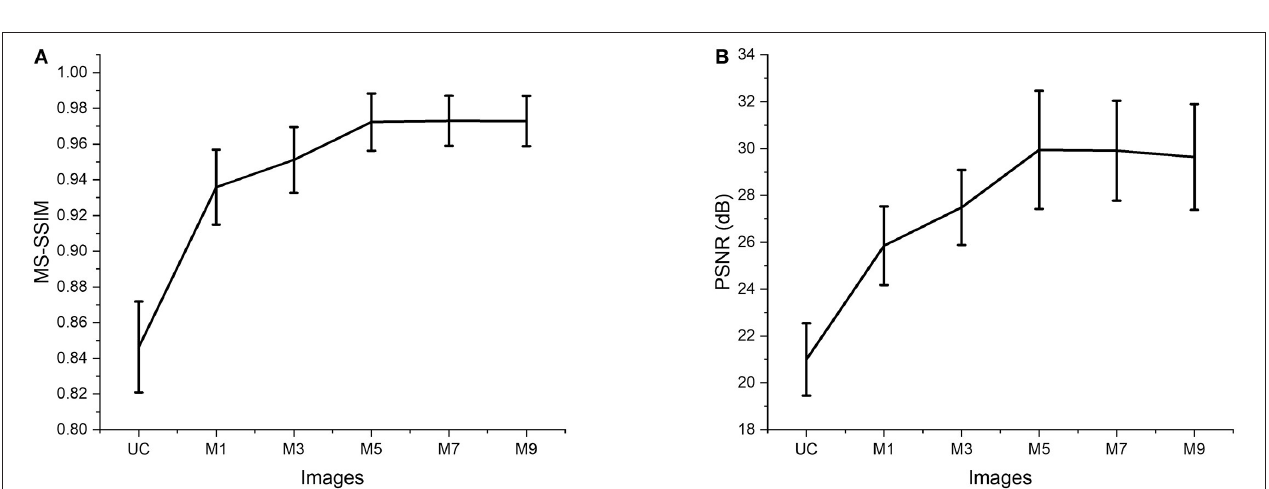
FIGURE 3 | (A) Representative OCT of a human retina with no dispersion compensation (A1) , and dispersion compensated by single (A2) , three (A3) , five (A4) , seven (A5) , and nine (A6) input channel models. (B) Corresponding differential intensity images which were generated by computing the pixel-to-pixel intensity differences between the ground truth image and the images in (A1–A6) , respectively.